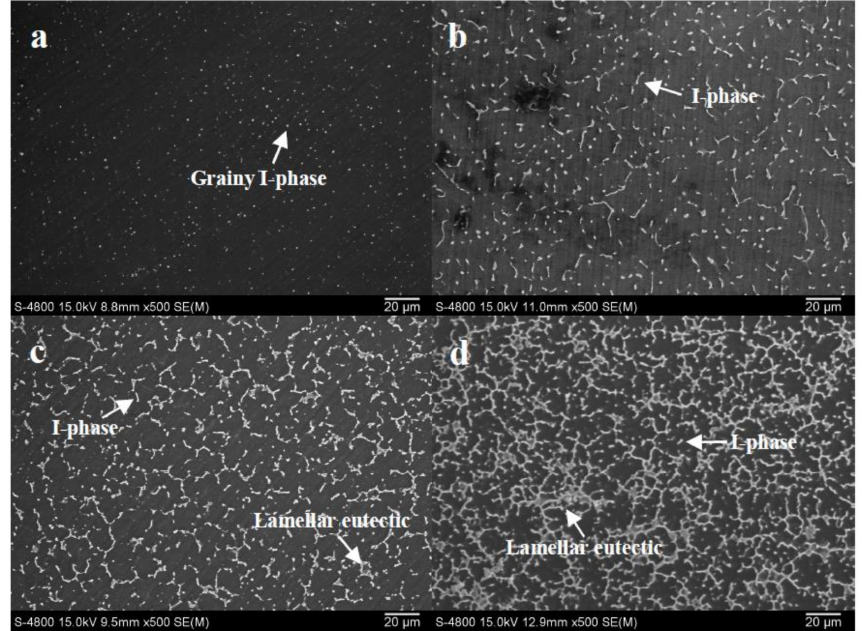
Figure 2. Scanning electron microscopy (SEM) images of as-cast Mg (100 − 7x) Zn 6x Y x alloys: ( a ) Alloy 1,